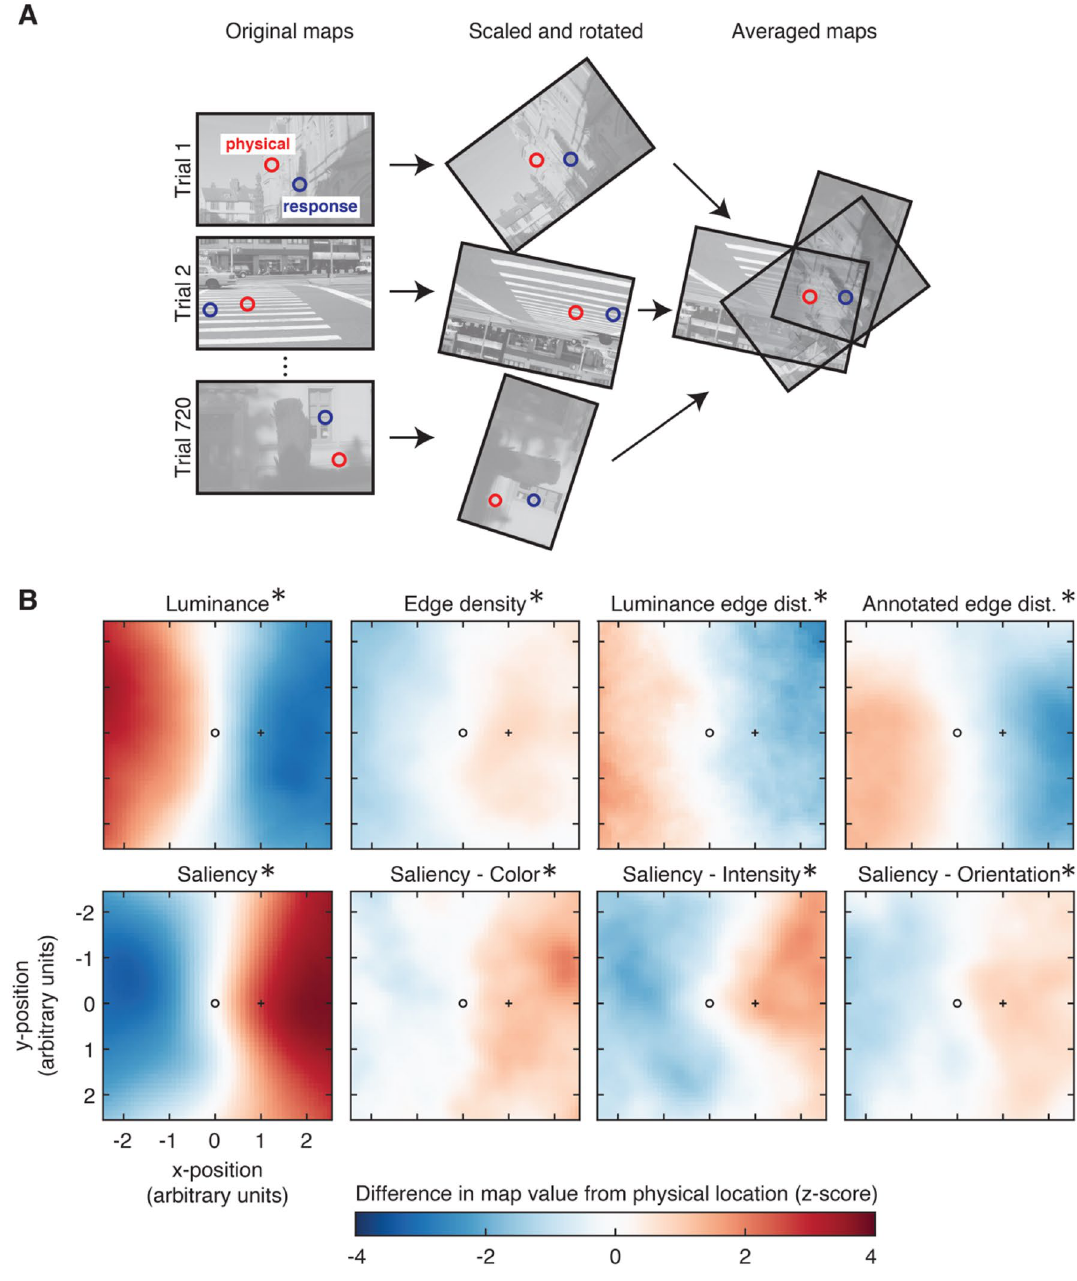
Figure 3. ( A ) Procedure for calculating averaged feature maps. Maps of each feature (in this example, luminance), were rotated and scaled to align the physical and response locations of each patch across all trials. The resulting maps were then averaged across trials, and across participants. ( B ) Averaged maps of each feature in Experiment 1. The coordinates x = 0, y = 0, indicated by the empty circle ( ○ ), correspond to the physical location of the patch, and the coordinates x = 1, y = 0, indicated by the plus symbol ( +) correspond to the location of the observer’s response. Following the procedures shown in Fig. 1C, values are shown as z-scores, calculated relative to a permuted null distribution of maps, where the SD for the calculation is the standard deviation of null distribution at the reported location. Asterisks indicate significant effects shown in Fig.